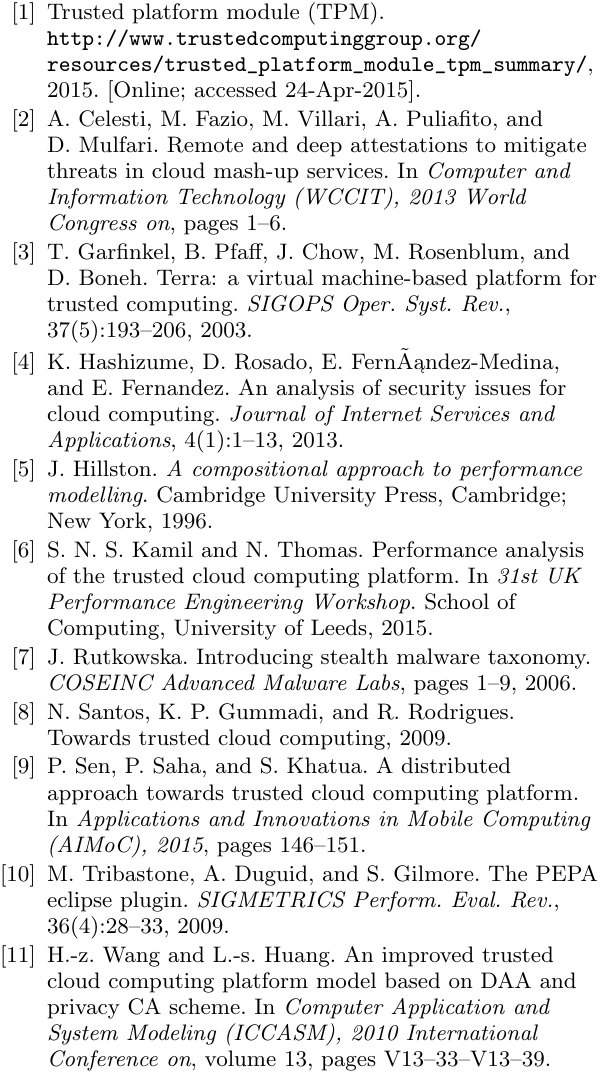
Figure 4: The throughput of the VM Launch Model, where number of CM ( C = 2) and probability of trust ( p = 0 . 8)